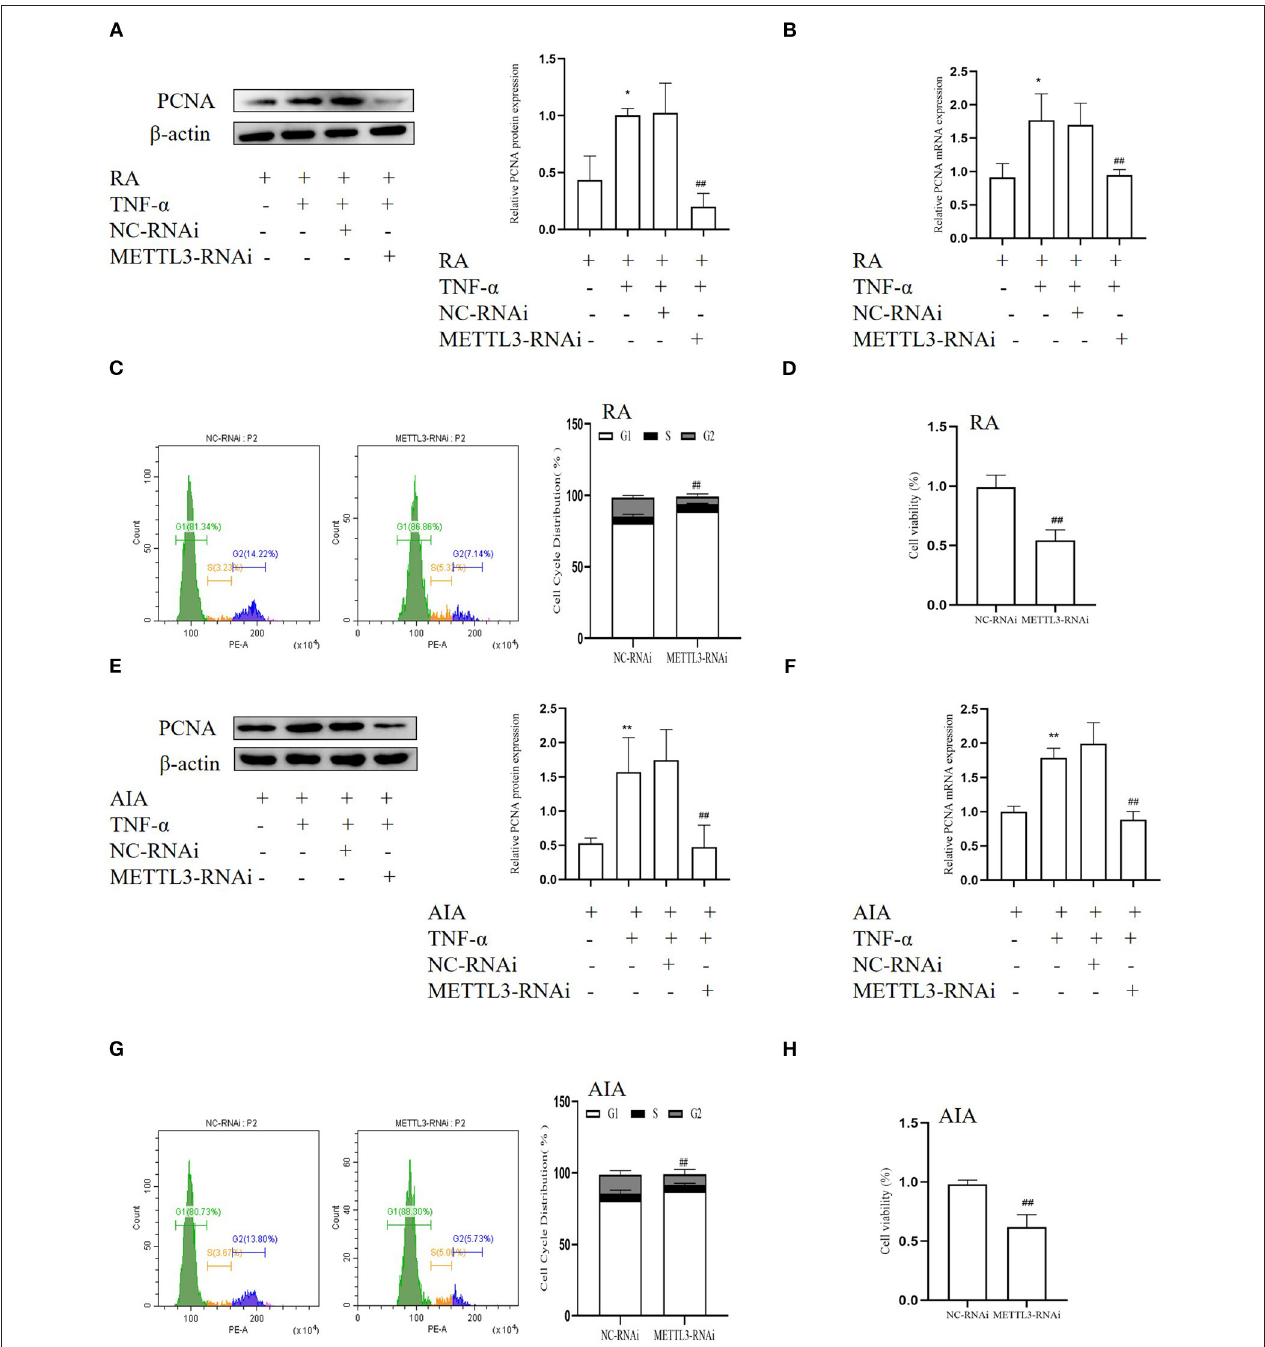
FIGURE 5 | Methyltransferase-like 3 (METTL3) silencing inhibits cell proliferation in fibroblast-like synoviocytes (FLSs). (A) Proliferating cell nuclear antigen (PCNA) protein levels in TNF- α -incubated rheumatoid arthritis (RA)-FLSs after METTL3 knockdown, as detected by Western blotting. (B) PCNA mRNA level was detected by real-time quantitative PCR (qPCR) in TNF- α -incubated RA-FLSs after transfection with METTL3-RNAi. (C) Cell cycle analysis after incubating with METTL3-RNAi for 48h, as assessed by fluorescence-activated cell sorting (FACS). (D) Cell growth of TNF- α -incubated RA-FLSs was measured by the 3-(4,5-dimethylthiazol-2-yl)-2,5-diphenyltetrazolium bromide (MTT) assay after transfection with METTL3-RNAi for 48h. (E) PCNA protein level was detected by Western blotting in TNF- α -incubated adjuvant-induced arthritis (AIA)-FLSs after METTL3 silencing. (F) PCNA mRNA level was analyzed by real-time qPCR after transfection with METTL3-RNAi in TNF- α -incubated AIA-FLSs. (G) Cell cycle analysis was measured by FACS after transfection with METTL3-RNAi for 48h. (H) Cell growth of TNF- α -incubated AIA-FLSs was analyzed by the MTT assay after transfection with METTL3-RNAi for 48h. All of these values are presented as the mean ± SD. NC , negative control. * P < 0.05, ** P < 0.01 vs. the control group. ## P < 0.01 vs. the NC group.